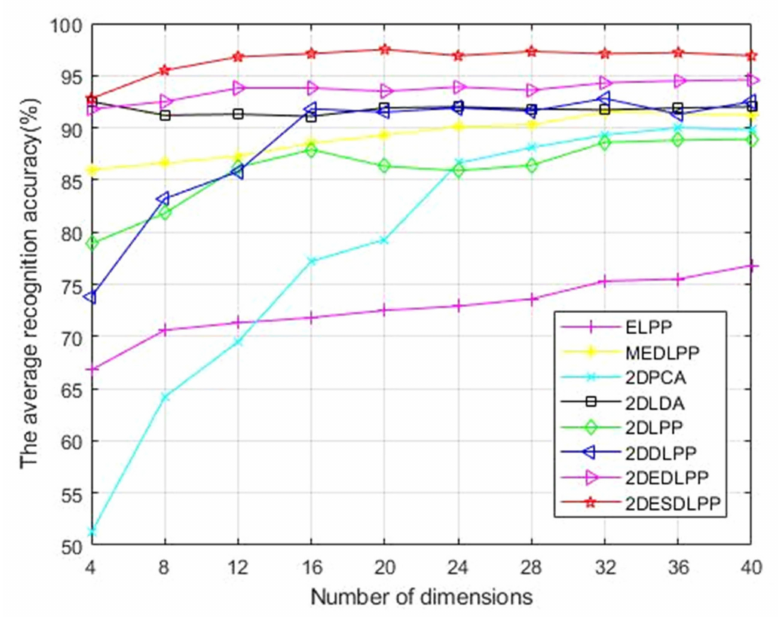
Figure 10. Average recognition rate (%) with feature dimension for different algorithms when the number of training samples in the AR face database is